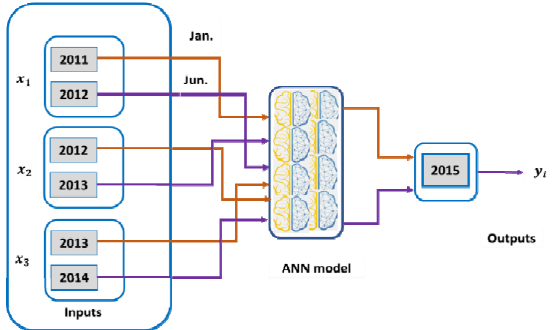
Figure 5. Description of the training parameters and input